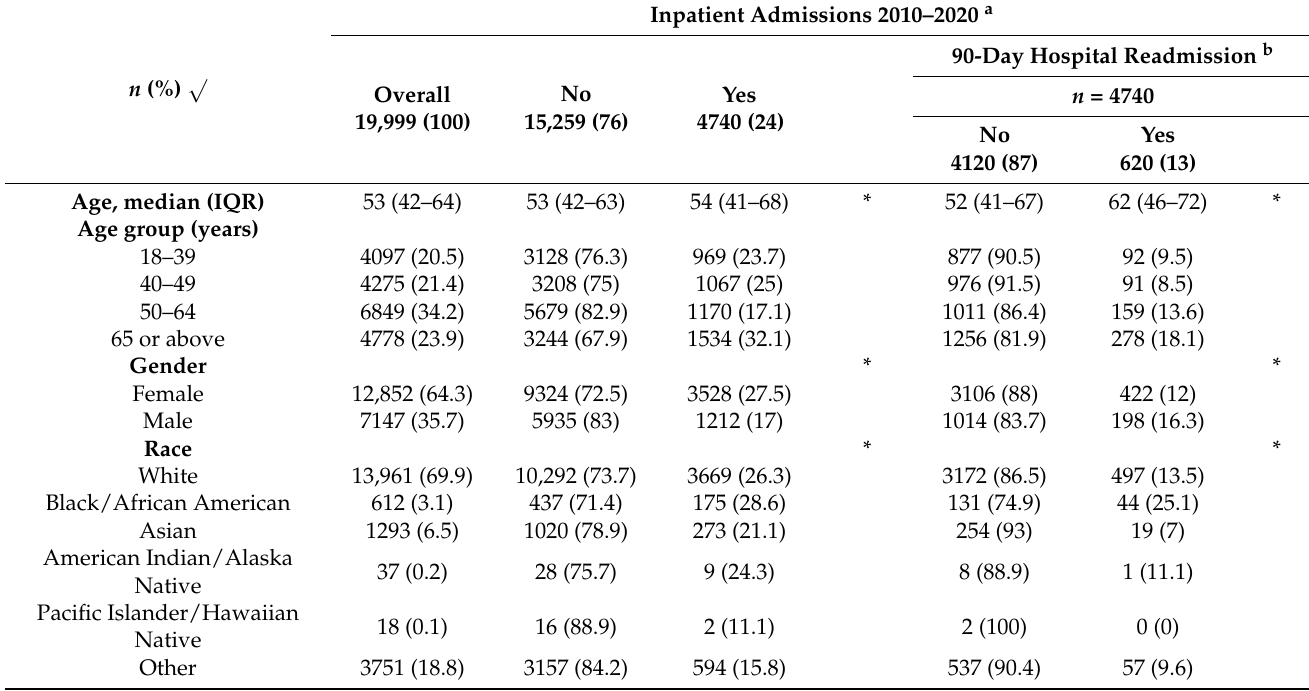
Table 1. Overall Study Population Sociodemographic and Clinical Characteristics ( n =